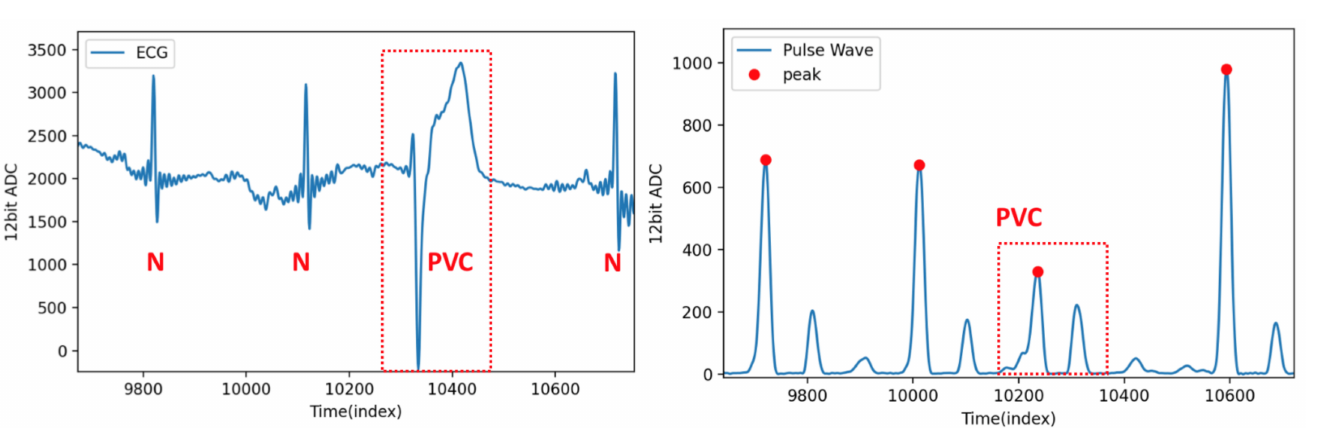
Figure 15. ECG and pulse wave signal sequence of a PVC patient.